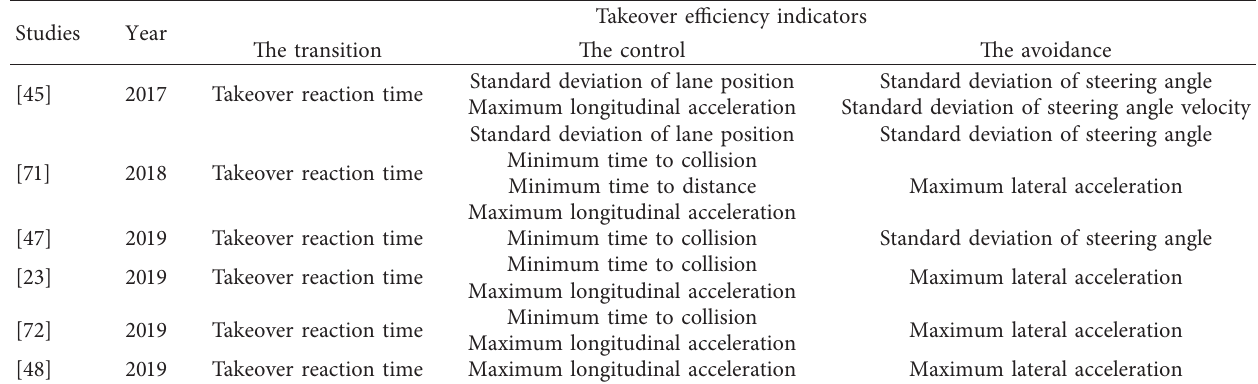
Table 2: Takeover efficiency indicators.